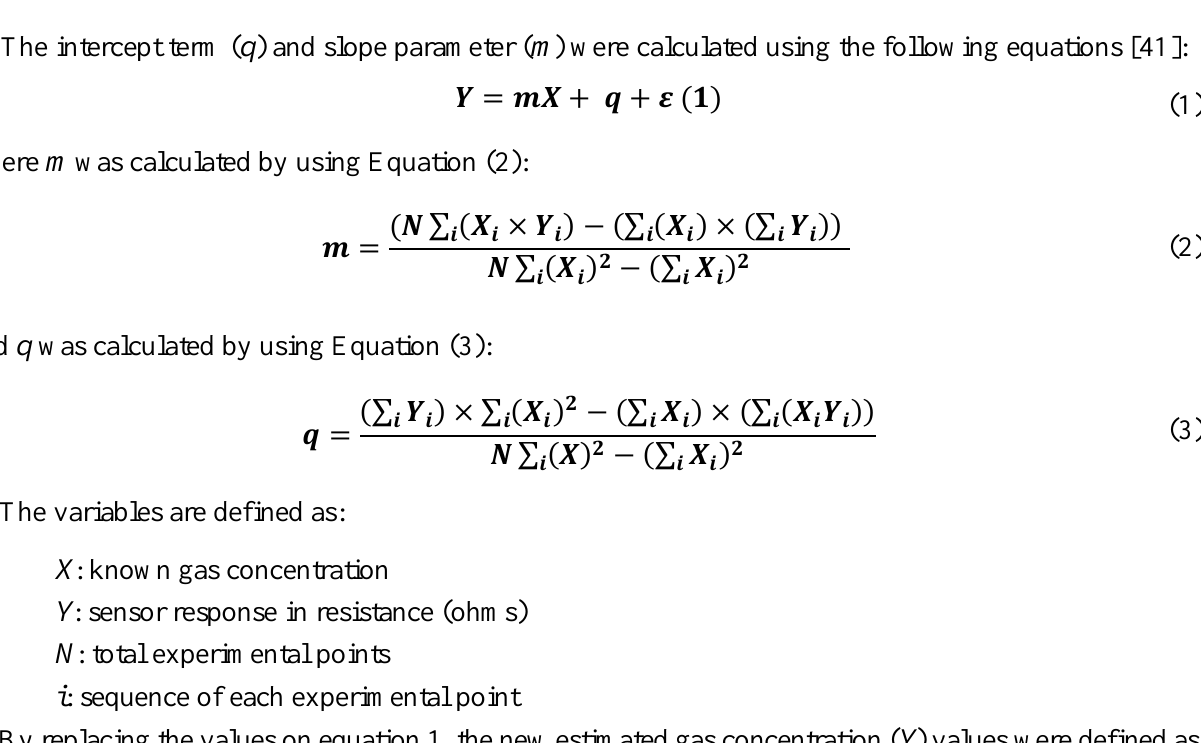
Figure 4. Linearization of the sensor response in resistance towards CH 4 concentrations from 0 to 10.5